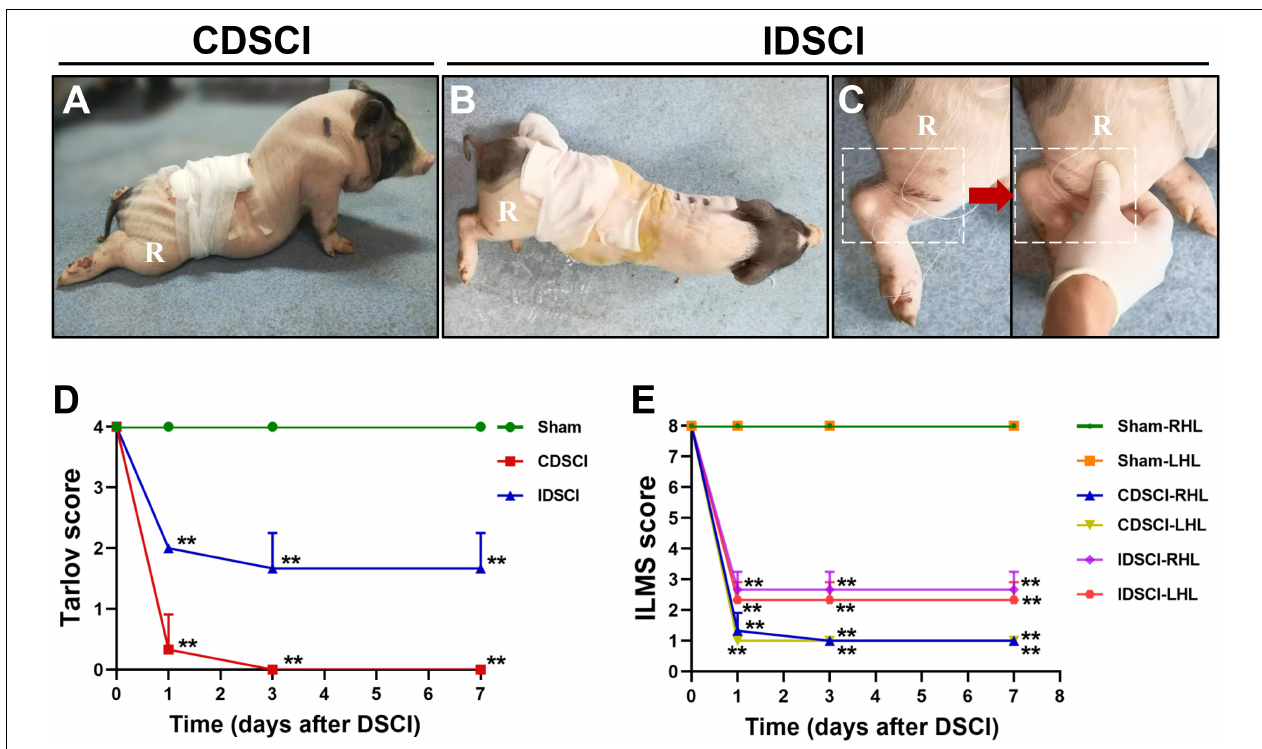
FIGURE 2 | The neurologic function changes in the hind limbs after DSCI. (A,B) The walking gait of pigs in the CDSCI and IDSCI groups was shown. (C) Muscle contraction was observed in the porcine hind limbs by stimulating the muscles in the IDSCI group. (D,E) The Tarlov and ILMS scale were used to functionally score the pigs of the sham, IDSCI, and CDSCI groups at the day 1, 3, and 7 post-surgery ( n = 3). All values are expressed as means ± SD. * P < 0.05, ** P < 0.01, vs. the sham group.